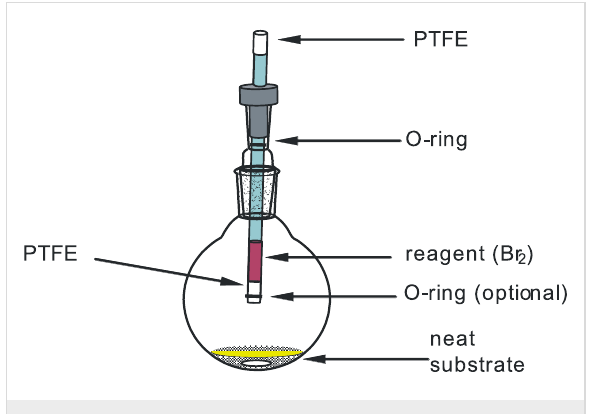
Figure 1: Solvent-free PV-PTFE reaction